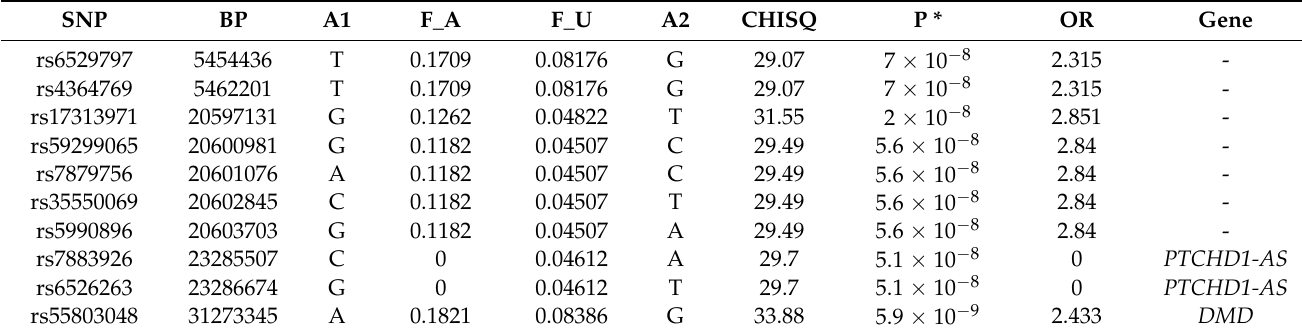
Figure 1. Identification of lung cancer risk sex-specific SNPs. ( A ) Manhattan plots of tested X chromosome SNPs. The distribution of the P-values of the X chromosome SNPs was plotted for the male (blue) and female (red) analyses. SNPs in the pseudo-autosomal regions, both PAR1 and PAR2, were not considered. The dashed line indicates the threshold for significant association as calculated by − log [0.05/171,804] where 171,804 was the number of X chromosome SNPs tested. The dotted line indicates the accepted threshold for analyses involving SNPs over the whole genome. ( B ) Heatmap showing p values of identified SNPs in subgroup association analysis. The cells in red indicate the SNPs whose p -values were significant. Table 1. Significant X chromosome SNPs associated with lung cancer in